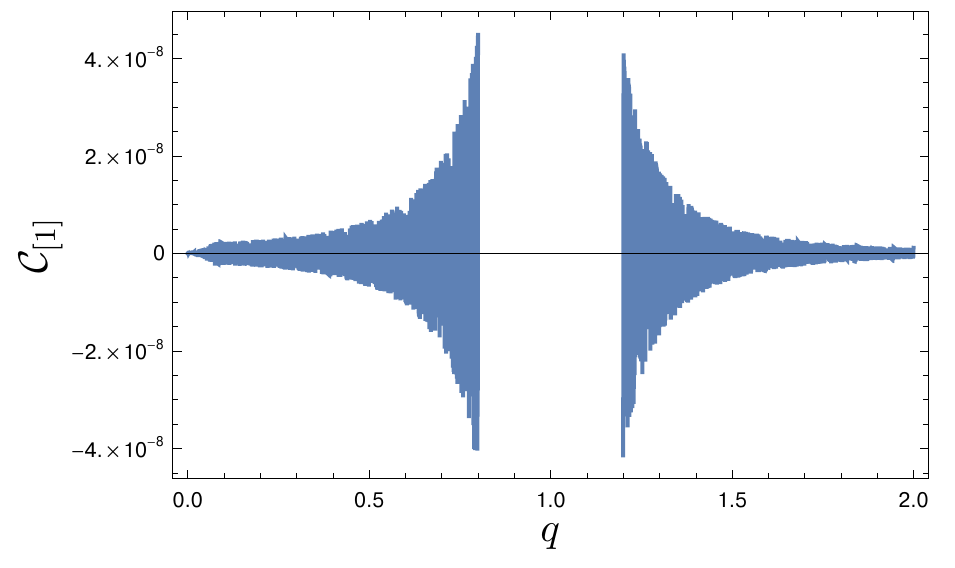
Figure 37 . Verification of the first law of thermodynamics — see (6.66) for a precise definition of — for the Klebanov-Tseytlin black holes to leading order in 1 / ln( µ/ Λ) as a function of q , C [1] equivalently T µ